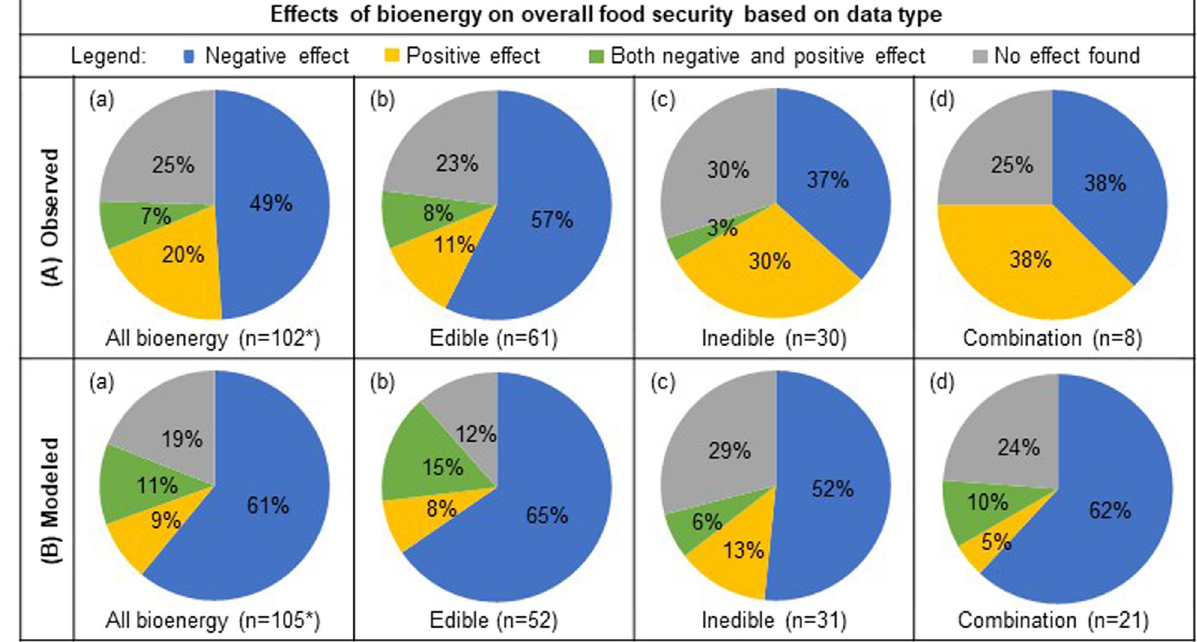
Fig. 7 Effects of bioenergy on overall food security based on observed data and modeled data. Percentage of reviewed publications that reported either negative, positive, both negative and positive, or neutral effect of all bioenergy (column a ), edible ( b ), inedible ( c ), and studies that included a combination of both edible and inedible feedstocks in their analysis ( d ) using observed data (row A ) and modeled datasets ( B ). *Bioenergy type “ not speci fi ed ” ( n = 4) is only included in “ All bioenergy ” (column a), and therefore the sum of edible, inedible, and both edible and inedible feedstocks (columns b – d ) will not necessarily be a composite of “ All bioenergy ” . Studies that used a composite of both observed and modeled data ( n = 17) are not included in the fi